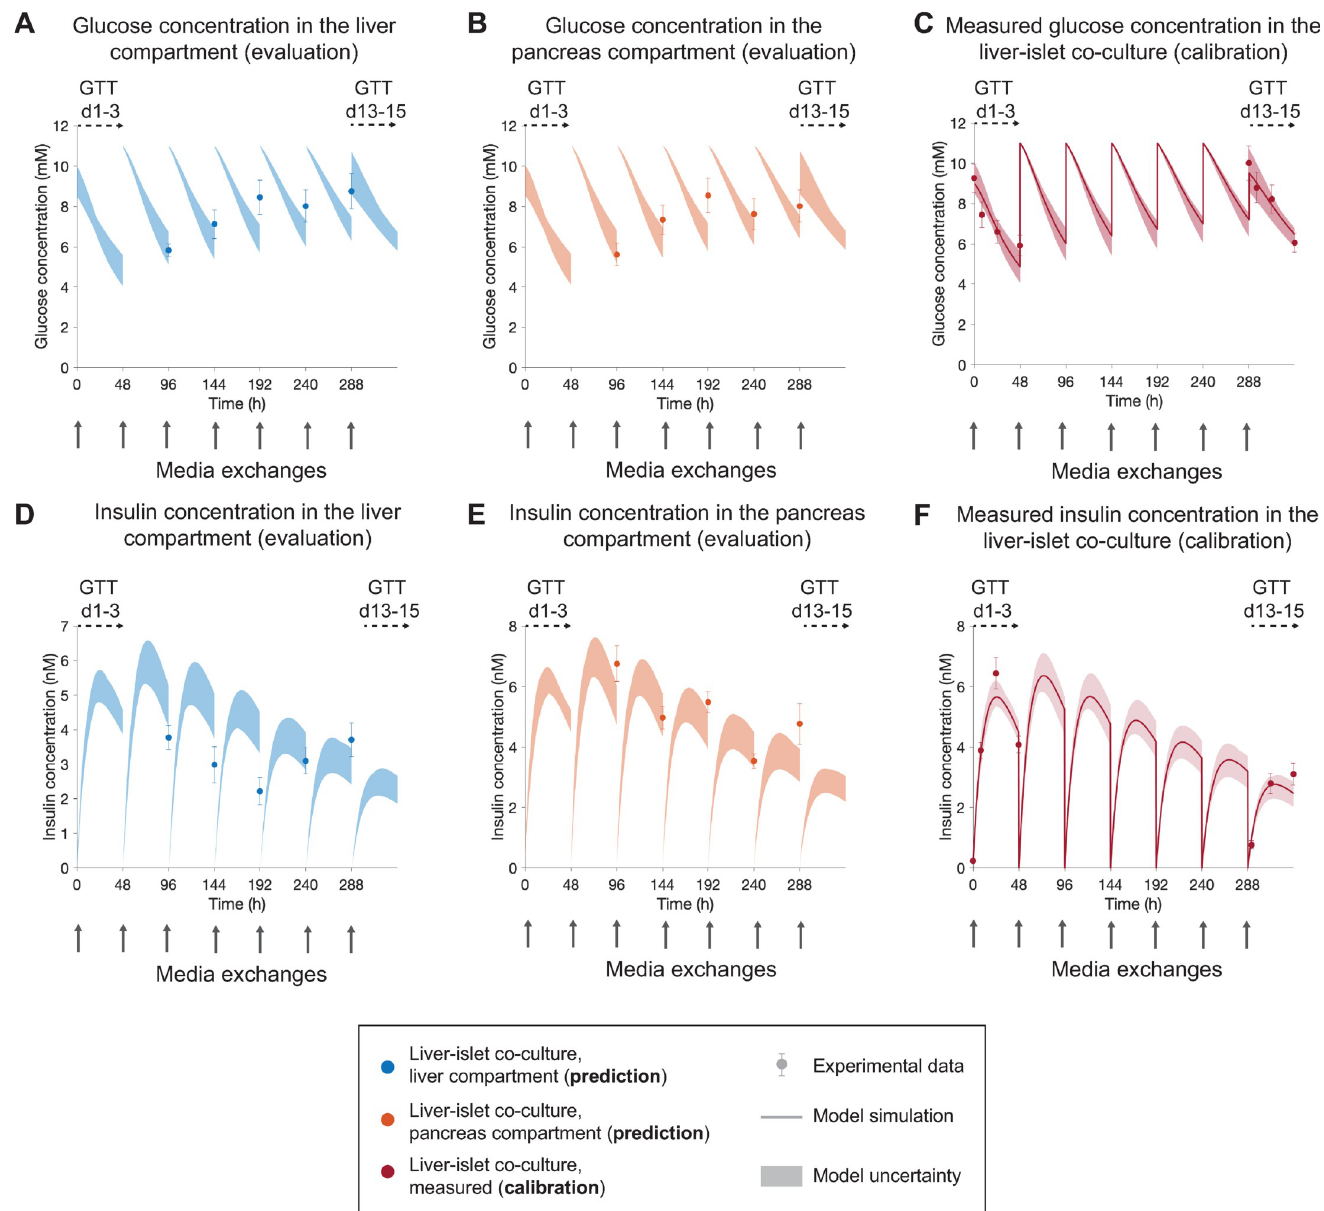
Fig 7. Model predictions of glucose and insulin concentrations in each organ compartment. The results correspond to a single experiment (experiment 2). A,B Comparison between model predictions of glucose in the liver and islets compartments, respectively, and the corresponding experimental data (markers). D,E Comparison between model predictions of insulin in the liver and islets compartments, respectively, and the corresponding experimental data (markers). Co- cultures were exposed to hyperglycemic medium (11 mM glucose) in each media exchange (grey arrows). The calibration data (C,F) consisted of glucose and insulin measurements acquired during GTTs initiated at day 1 (GTT d1-3) and day 13 (GTT d13-15). In the calibration data (C,F) , glucose and insulin concentrations were measured by pooling samples of 15 μ L from each compartment (i.e. measuring the average concentration of the two compartments), while concentrations in the evaluation dataset (A,B,D,E) were measured independently in each culture compartment (liver or pancreas). Data points for evaluation were acquired 48 hours following each media exchange between days 3 and 13. Model uncertainty is depicted as shaded areas in (A-F) . Data are presented as mean ± SEM, n = 10. n: Number of platform replicates included in the